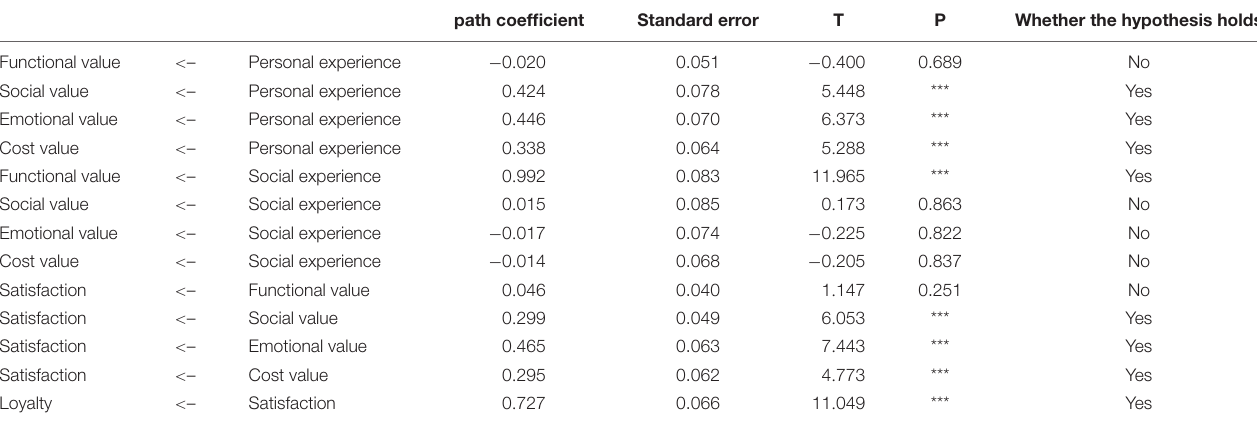
TABLE 2 | Conclusion of structural equation